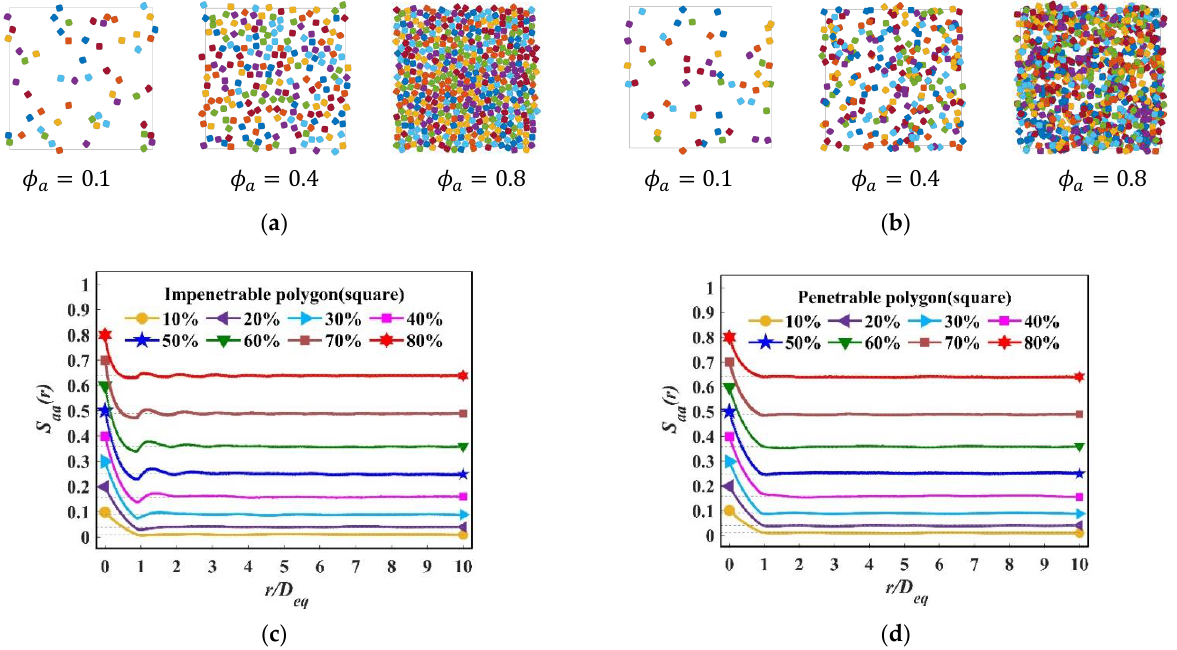
Figure 7 . ( a ) Examples of impenetrable packs of super-ellipse, 𝑎 𝑏⁄ = 1 , 𝑚 = 2 ; ( b ) Examples of Figure 7. ( a ) Examples of impenetrable packs of super-ellipse, a / b = 1, m = 2; ( b ) Examples of penetrable packings for super-ellipse, 𝑎 𝑏⁄ = 1 , 𝑚 = 2 ; ( c ) 𝑆 𝑎𝑎 (𝑟) for impenetrable super-ellipse, penetrable packings for super-ellipse, a / b = 1, m = 2; ( c ) S aa ( r ) for impenetrable super-ellipse, with with various packing fraction; ( d ) 𝑆 𝑎𝑎 (𝑟) for penetrable super-ellipse, with various packing frac- various packing fraction; ( d ) S aa ( r ) for penetrable super-ellipse, with various packing tion.